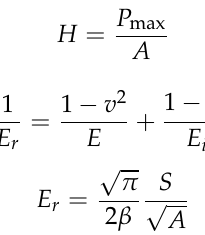
Figure 6. Load–crystal modulus of elasticity curve.